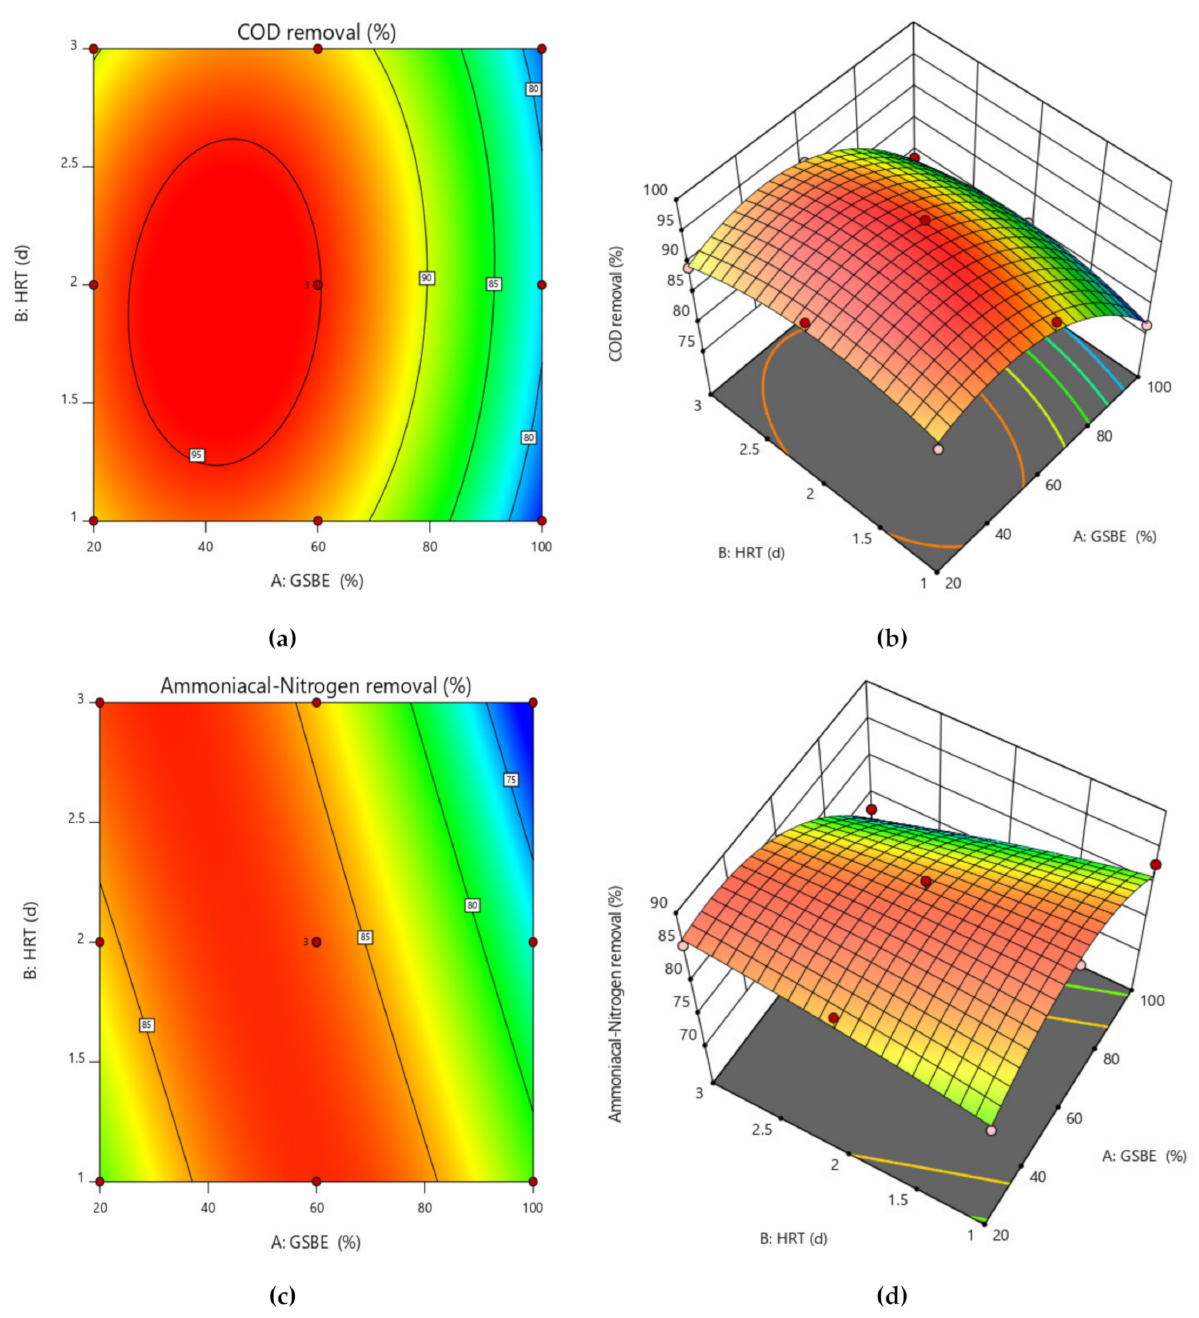
Figure 7. Contour and surface plot for ( a , b ) COD removal percent and ( c , d ) NH 4+ − N removal percent from the SB-CMAS bioreactor